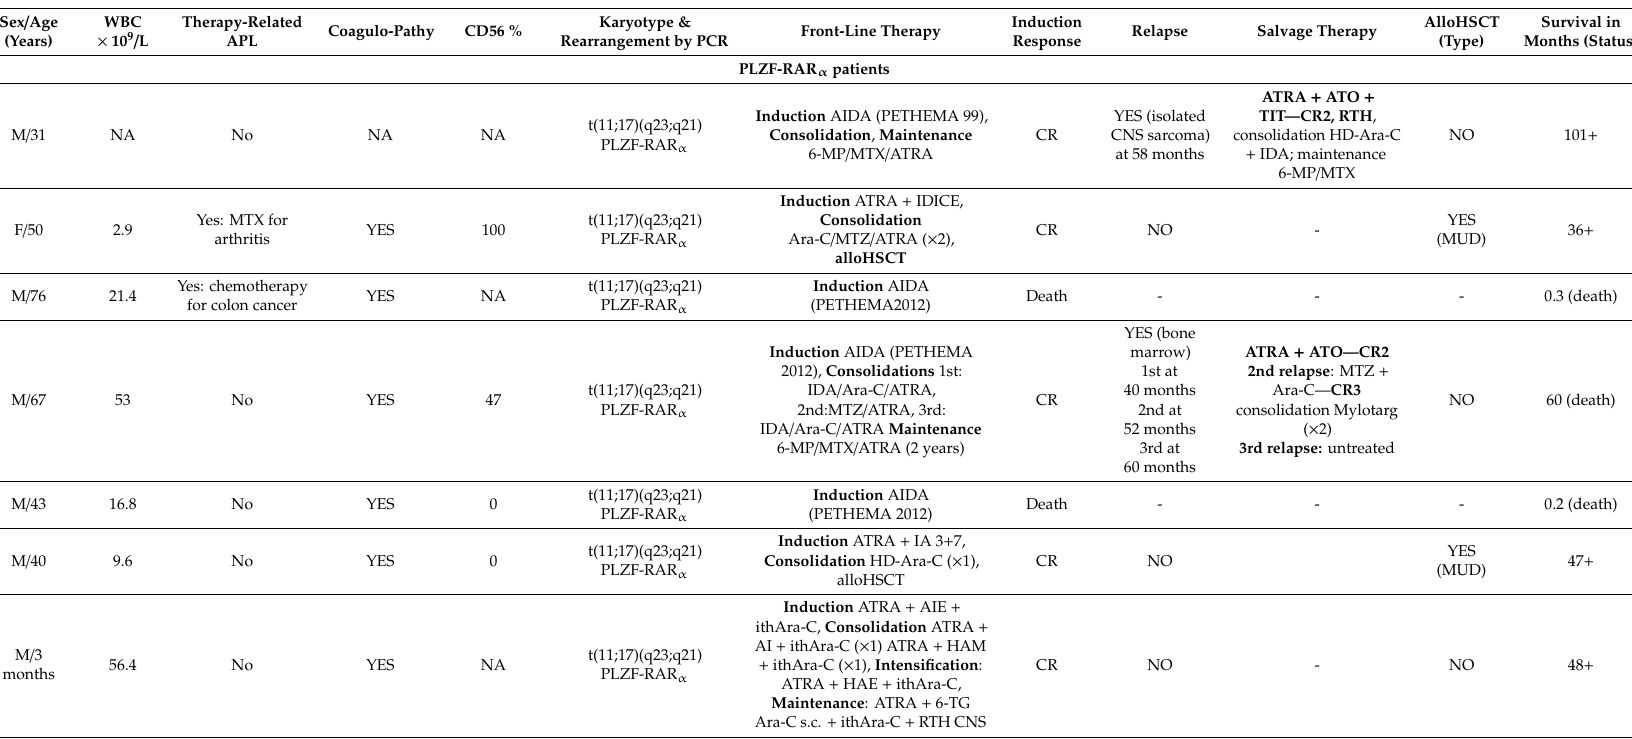
Table 1. Clinical characteristics, treatment, and outcomes of 11 variant acute promyelocytic leukemia (APL) patients reported to the PETHEMA registry. Sex / Age